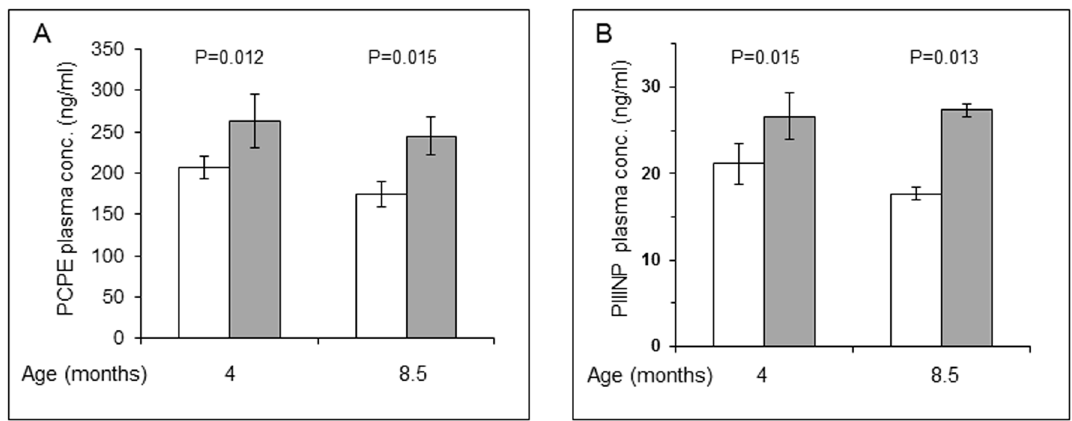
Fig 3. Plasma concentrations of PCPE-1 in mdx mice are higher than in the respective controls and the increase is comparable to that of PIIINP. (A) Plasma concentrations of PCPE-1 were determined using the current sandwich ELISA. Results are presented as the mean ± SD (n = 8). ( B) Plasma concentrations of PIIINP were determined using a commercial kit. Each plasma sample was diluted 10 fold in blocking buffer and PIIINP concentrations were determined in duplicates. The results are presented as mean ± SD (n = 4 rather than 8 as in the case of PCPE-1 determination). This has to do with the high cost of the PIIINP kit. Nonetheless, and importantly, the results derived from four plasma samples were statistically